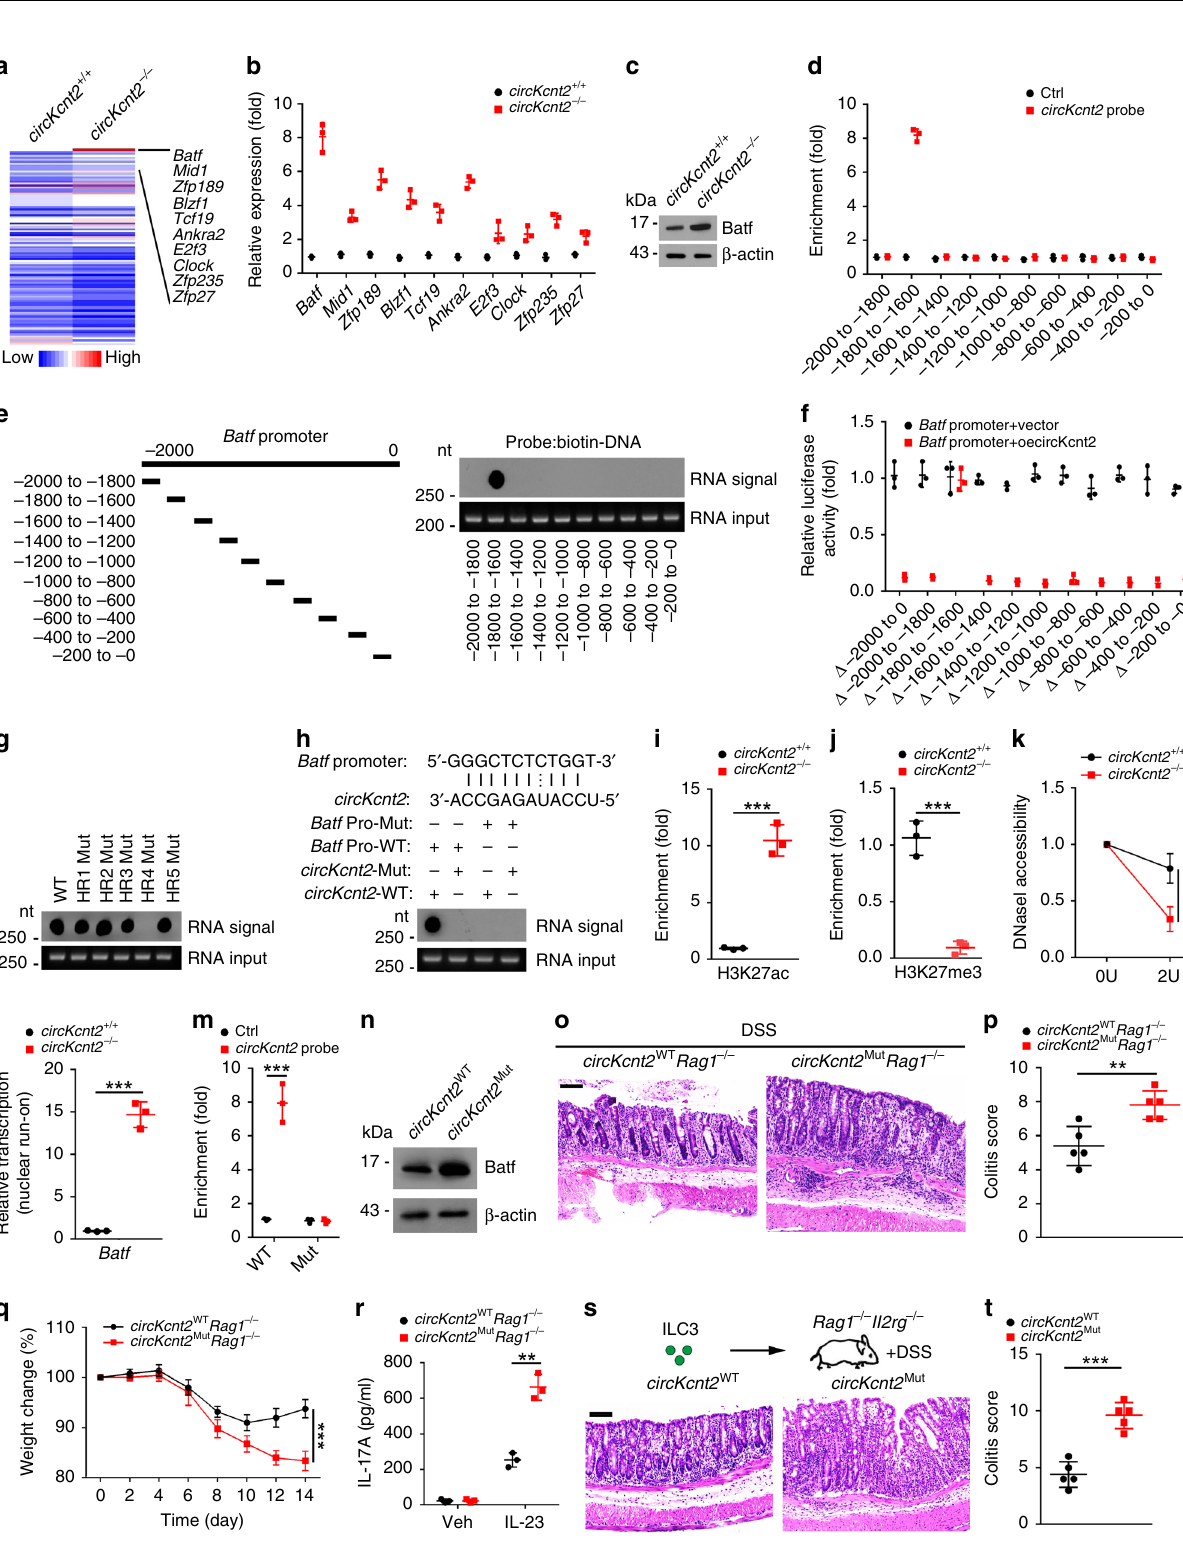
Consistently, circKcnt2 de fi ciency caused elevated transcription of Batf mRNA by nuclear run-on assay (Fig. 3l). These data indicate that circKcnt2 interacts with Batf promoter to suppress its transcription. To further con fi rm the in vivo role of their pairing bases, we generated circKcnt2 -mutant (called circKcnt2 Mut ) mice through knocking in the mutation bases of pairing circKcnt2 region